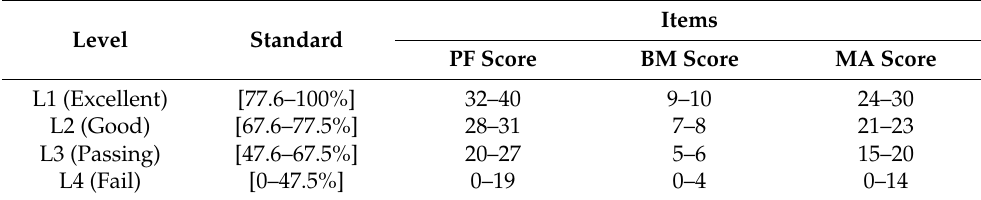
Table 1. Classification of PF evaluation level for